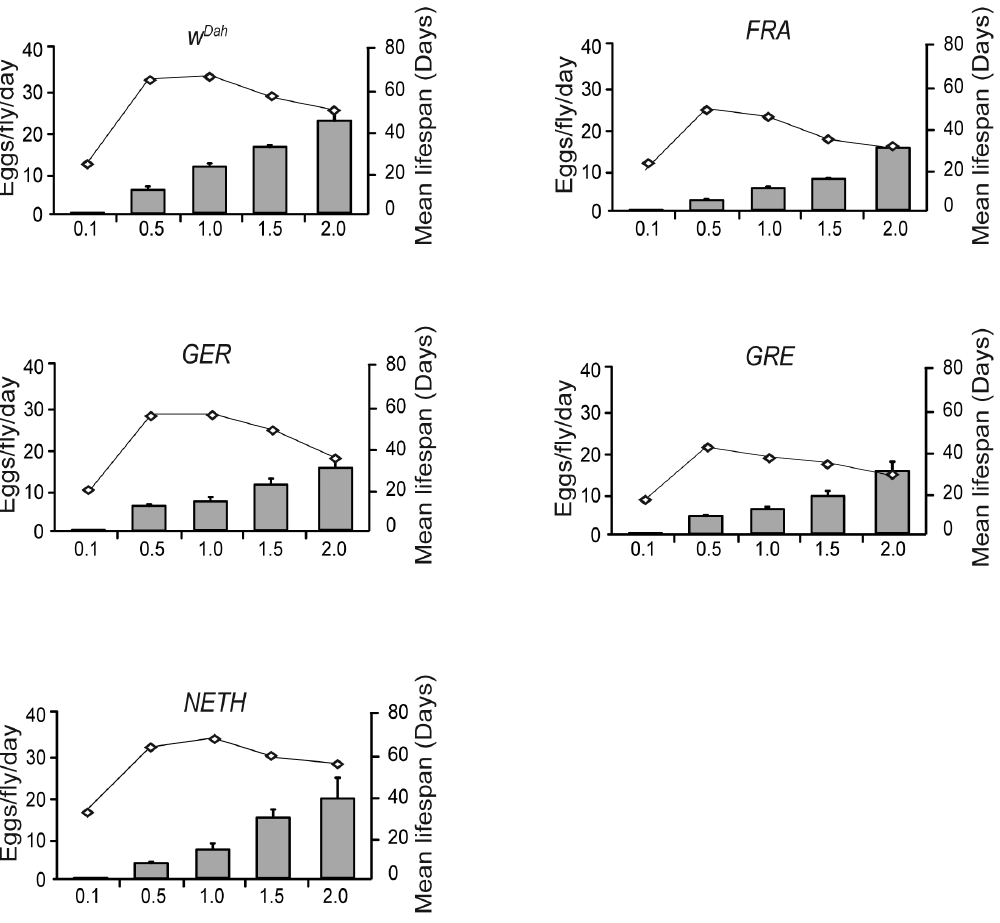
Figure 1. Lifespan and fecundity of wild–derived Drosophilamelanogaster strains responded to DR. The mean lifespans of all wild-derived strains and the laboratory strain exhibited a tent-shaped response to DR with highest mean lifespan values at 0.5 or 1.0 yeast concentration. Female fecundity showed a monotonic increase with yeast concentration in all strains. Both mean lifespan and fecundity were significantly affected by food. Mean lifespan for W Dah : F=94.21, R 2 =0.8933, p , 1 6 10 2 4 , for FRA : F=35.42, R 2 =0.7589, p , 1 6 10 2 4 , for GRE : F=81.23, R 2 =0.8784, p , 1 6 10 2 4 , for GER : F=96.66, R 2 =0.8957, p , 1 6 10 2 4 , for NETH : F=43.25, R 2 =0.7936, p , 1 6 10 2 4 , one-way ANOVA test. Fecundity for W Dah : F=136.5, R 2 =0.9239, p , 1 6 10 2 4 , for FRA : F=158.3, R 2 =0.9337, p , 1 6 10 2 4 , for GRE : F=103.1, R 2 =0.9016, p , 1 6 10 2 4 , for GER : F=107.6, R 2 =0.9054, p , 1 6 10 2 4 , for NETH : F=123.5, R 2 =0.9165, p , 1 6 10 2 4 , one-way ANOVA test. Points: mean lifespan. Bars: estimate of mean number of eggs laid/fly/day 6 standard error; connected points: mean lifespan in days ( n =100). Data shown are from a single trial with second generation flies of the wild-derived